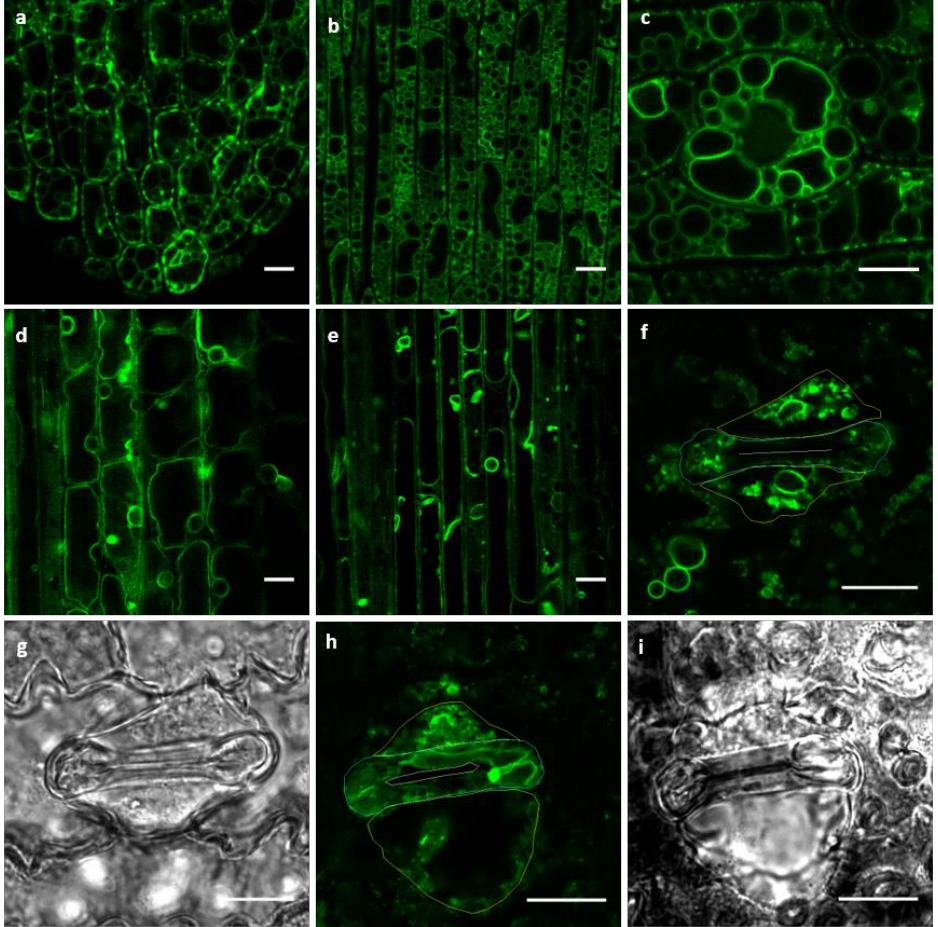
Figure 2. Vacuole morphology differences across multiple rice leaf cells. ( a , b ) Coleoptile epidermal cells are enriched with small bubble-like vacuoles. Coleoptiles, five days post-germination, were used to take images from the tip ( a ) and middle ( b ) regions. ( c ) The stomata in the coleoptile was packed with fragmented vacuoles. ( d,e ) Central vacuoles in true leaves. The big central vacuoles occupied most of the leaf pavement cells ( d ) and developing veins ( e ). ( f ) Vacuoles in closed stomata of true leaf. ( g ) The corresponding bright field channel of ( f) . ( h ) Vacuoles in opened stomata of true leaf. ( i ) The corresponding bright field channel of ( h) . Yellow and blue lines indicate the cell boundaries of subsidiary cells and guard cells, respectively. White lines indicate the pore region of the stomata. Scale bars: 10 µm.